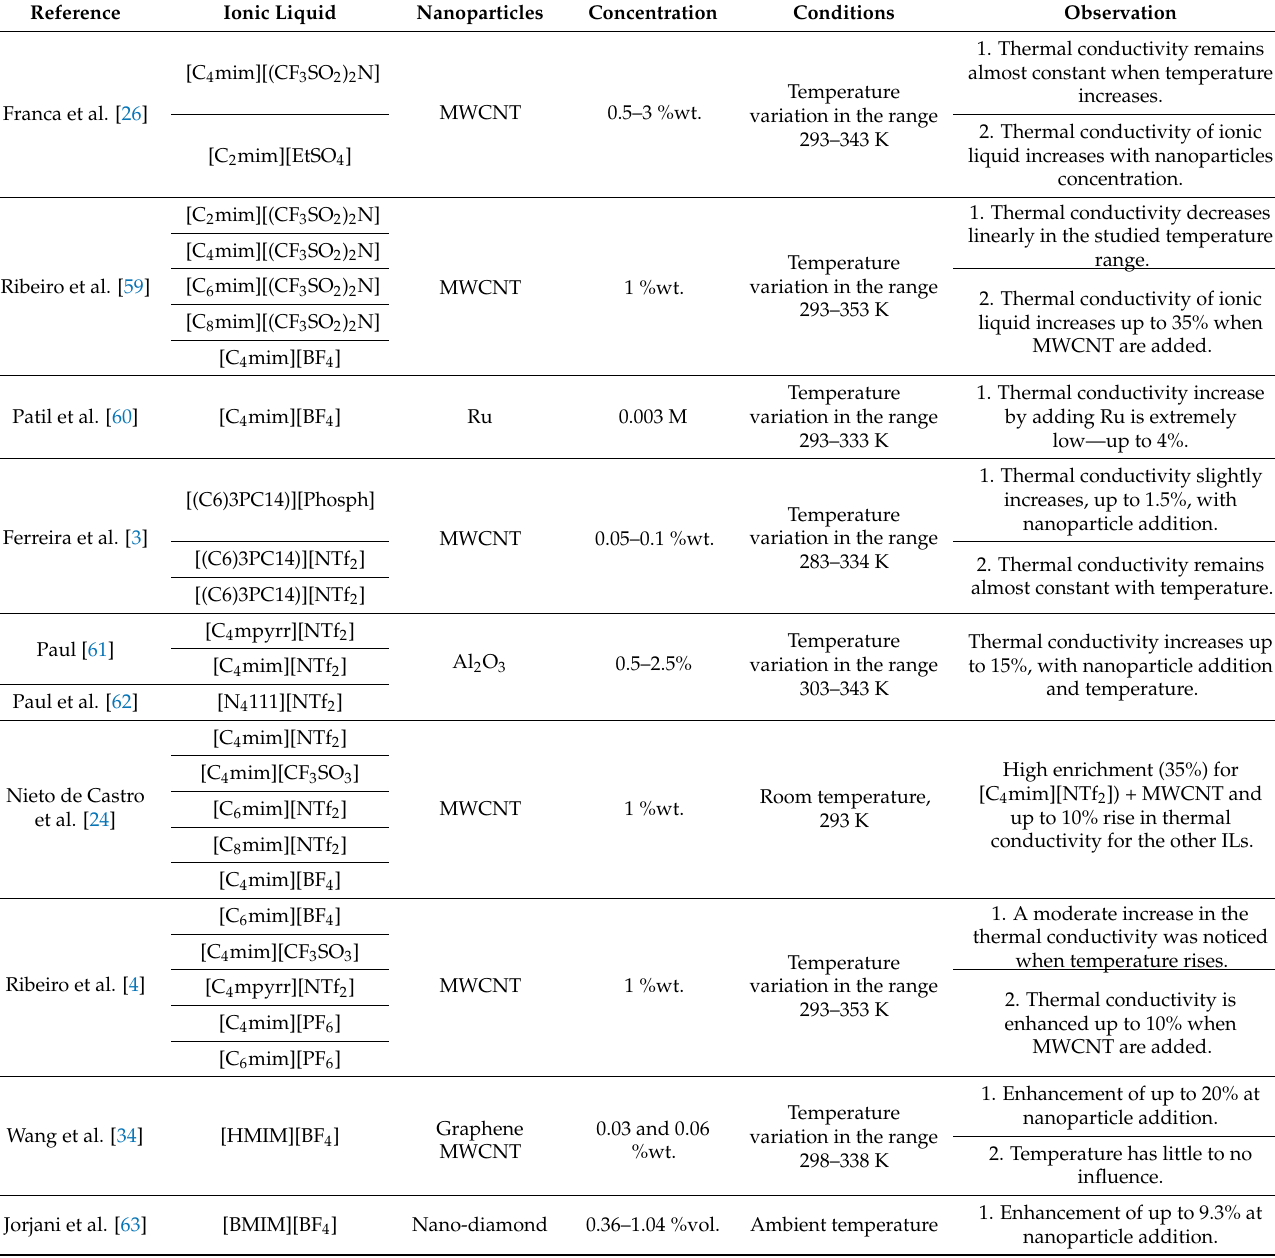
Table 3. Literature results on thermal conductivity of ionic liquid-based